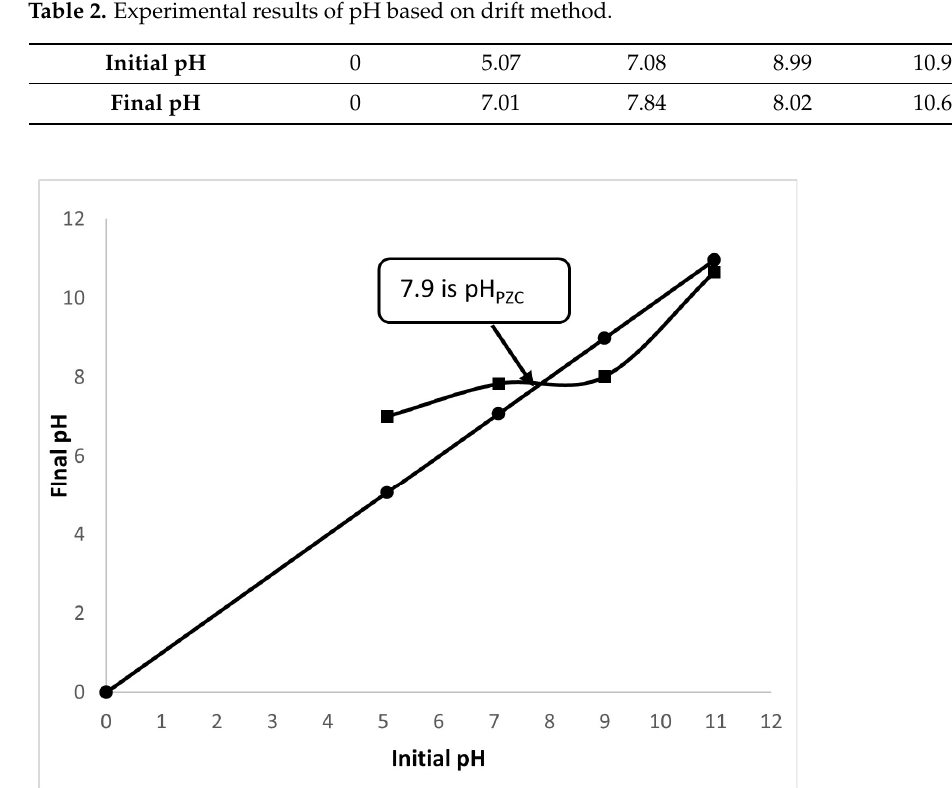
PZC ) of Ag-TiO 2